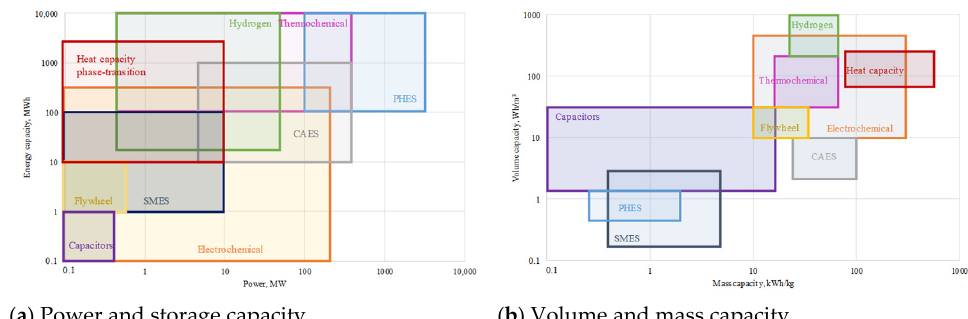
Figure 9. Main performance of energy accumulation systems.